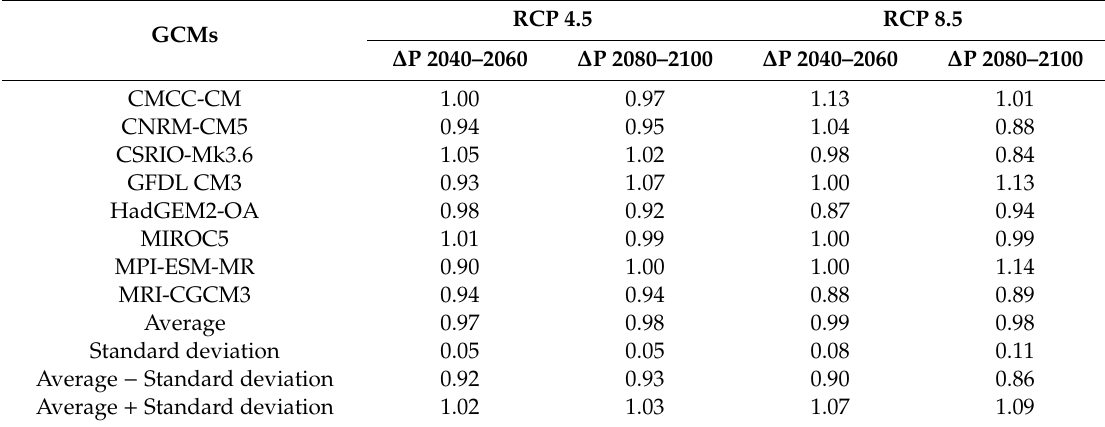
Table 4. Determination of lower and higher precipitations changes under each RCP from the selected